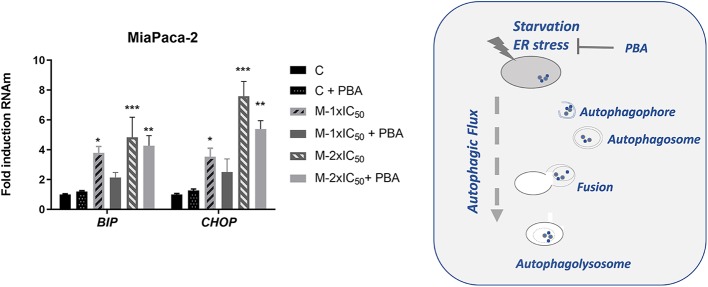
Marigold SFE induces the expression of BIP and CHOP. Effect of marigold SFE on the expression levels of BIP and CHOP of MiaPaca-2 cells pretreated at two different doses corresponding to 1 × IC50 and 2 × IC50 for 48 h, in the presence or absence of PBA. Non-treated cells were kept as controls. Data represent the mean ±_S.E.M of three independent experiments, each one performed in triplicate. Asterisks indicate statistical differences in treated cells in comparison with control (DMSO); *P < 0.05, **P < 0.01, ***P < 0.005.